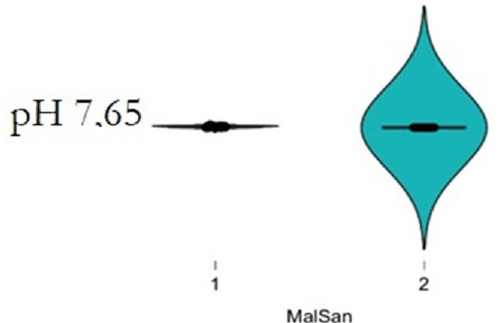
Figure 3. Boxplot representation of pH distribution in the first day after the admission patients (1) compared with healthy (2) stratified by pH concentration. Of note, COVID-19 status ( p = 0.005) and pH ( p < 0.001) are significantly associated with clinical values in a multivariable linear regression analysis of sex, age, and COVID-19 status.